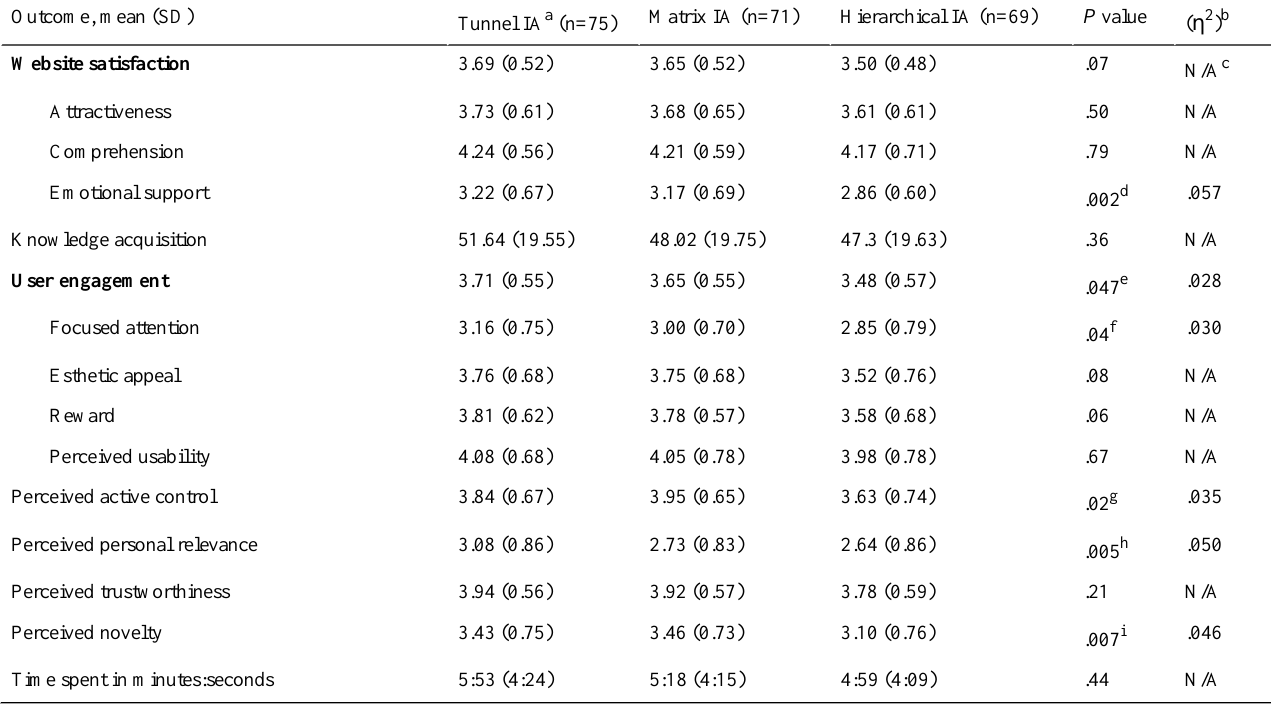
Table 3. Knowledge acquisition, satisfaction, and user perceptions of patient education website by information architecture.